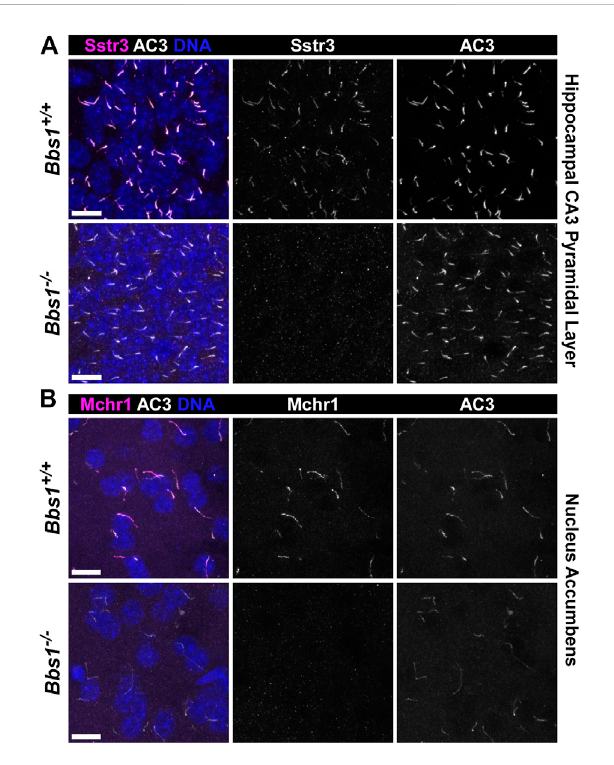
FIGURE 1 Bbs1 − / − mice lack Sstr3 and Mchr1 ciliary localization in the brain (A) Representative images of the pyramidal layer of the hippocampal CA3 region from adult Bbs1 +/+ (upper row) and Bbs1 − / − (lower row) mice colabeled for Sstr3 (magenta) and AC3 (white). Sstr3 localized to 74%(623/846; n =3animals)ofAC3-positiveciliain Bbs1 +/+ sectionsand 0% (0/417; n = 3 animals) of AC3-positive cilia in Bbs1 − / − sections (B) Representative images of the nucleus accumbens from adult Bbs1 +/+ (upper row) and Bbs1 − / − (lower row) mice colabeledfor Mchr1 (magenta) andAC3(white).Mchr1localizedto72%(675/938; n =3animals)ofAC3- positive cilia in Bbs1 +/+ sections and 0% (0/471; n = 3 animals) of AC3- positive cilia in Bbs1 − / − sections. Nuclei are stained with DRAQ5 (blue). Scale bars represent 10